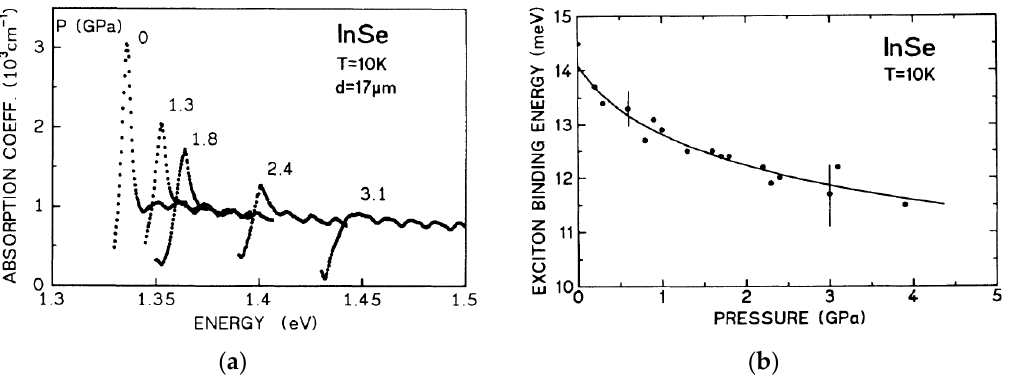
Figure 9. InSe optical properties under pressure. ( a ) InSe fundamental absorption edge at 10 K and different pressures. ( b ) Pressure dependence of the exciton binding energy in InSe [58].